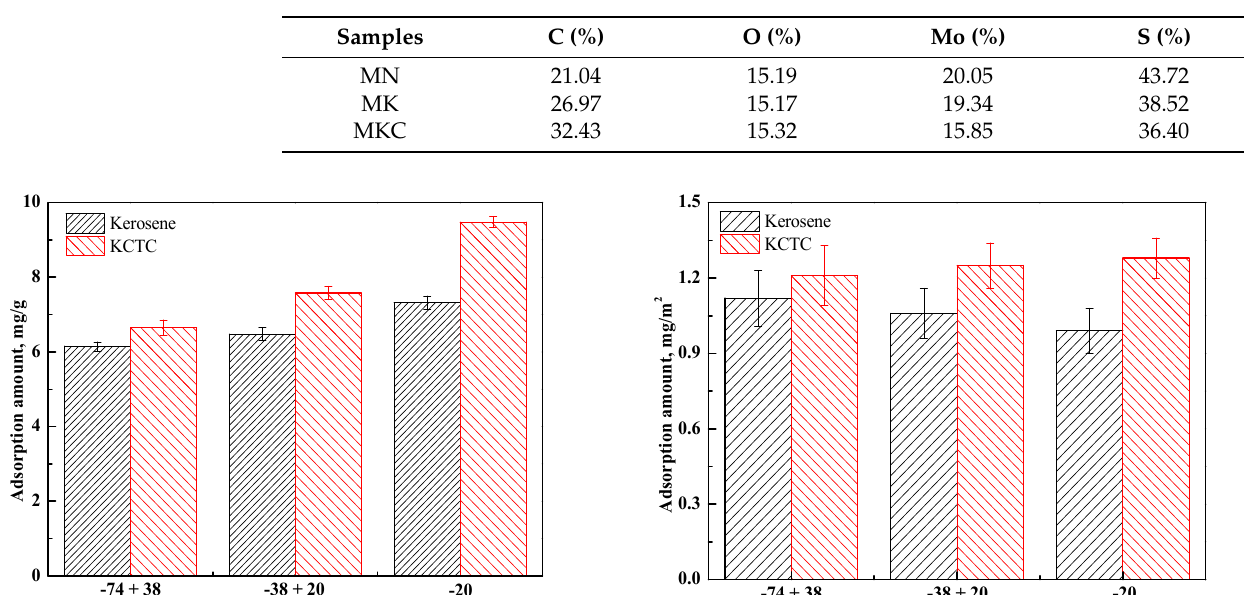
Figure 10. Adsorption amount of kerosene and KCTC on molybdenite particles of different sizes.